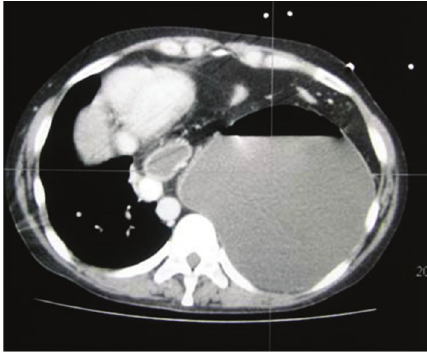
Figure 13: Axial CT on the same patient as Figure 13 showing diaphragmatic rupture and herniation of the stomach into the left hemithorax.